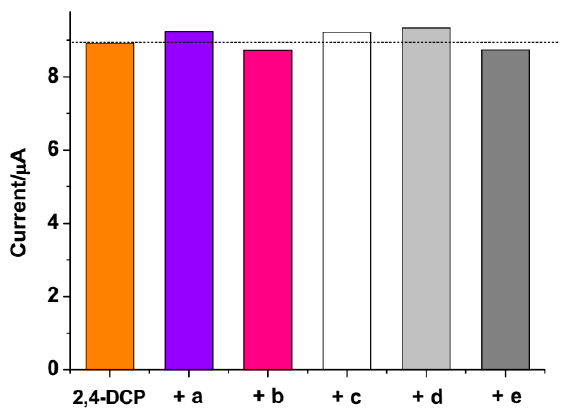
Figure 6. The peak current changes of 0.3 µ M 2,4-DCP at MIPs/Fe 3 O 4 /GCE with addition of 5-fold concentration of interference species: ( a ) 2-chlorophenol; ( b ) hydroxyphenol; ( c ) pentachlorophenol; ( d ) 2,4,6-trichlorophenol; ( e ) hydroquinol.